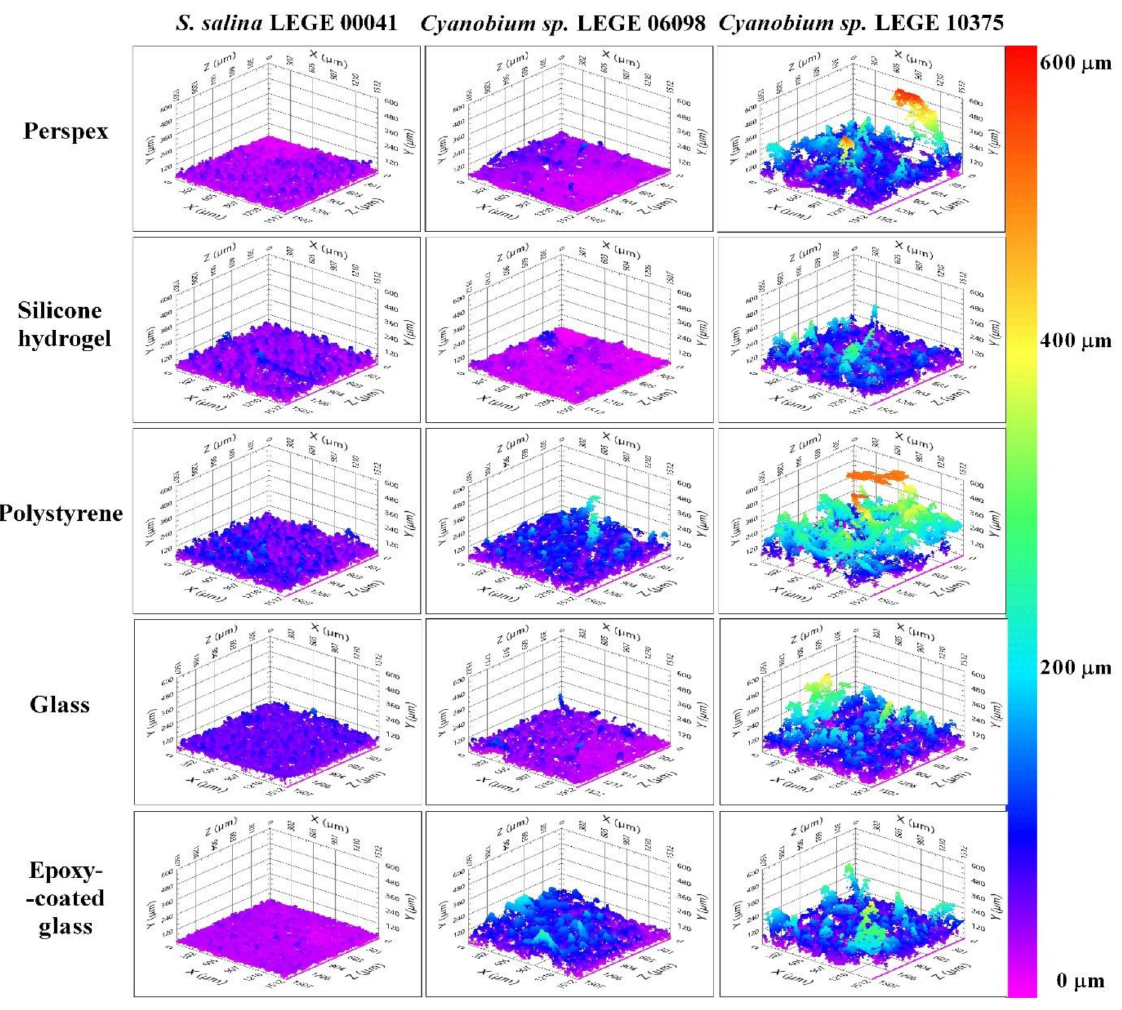
Figure 3. Representative 3D OCT images obtained for S. salina LEGE 00041, Cyanobium sp. LEGE 06098, and Cyanobium sp. LEGE 10375 biofilms formed on perspex, silicone hydrogel, polystyrene, glass, and epoxy-coated glass surfaces after 49 days. The color scale shows the range of biofilm